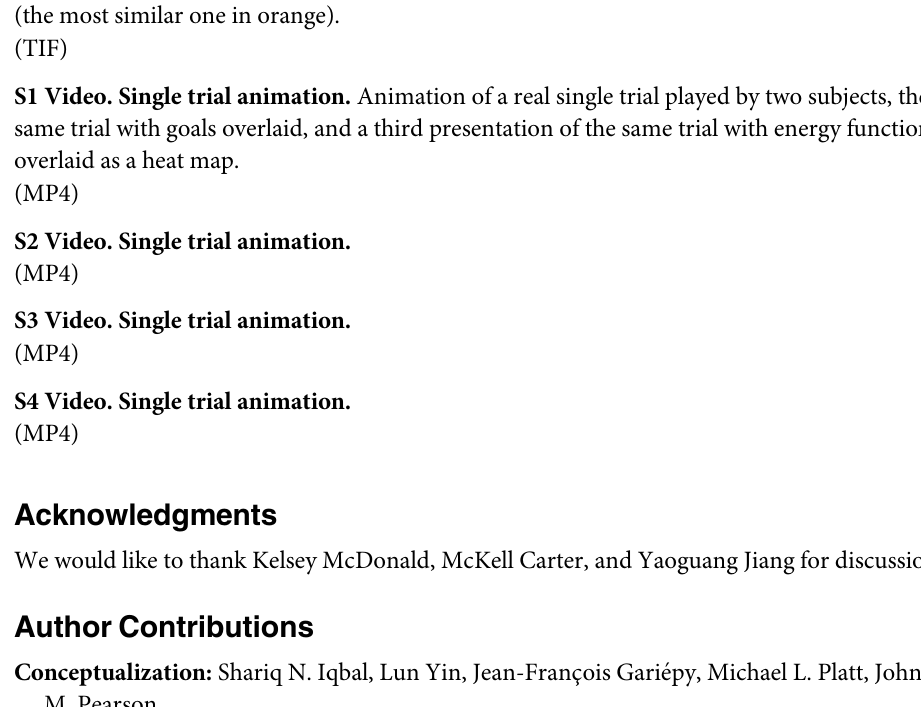
S3 Fig. Generated trials matched with actual trials. For 30 random trajectories generated by our model, we located and plotted the closest 20 trials (in mean-squared state space error) in the training data set. The generated trajectories are in black and the matched ones are in blue (the most similar one in orange). S1 Video. Single trial animation. Animation of a real single trial played by two subjects, the same trial with goals overlaid, and a third presentation of the same trial with energy function overlaid as a heat